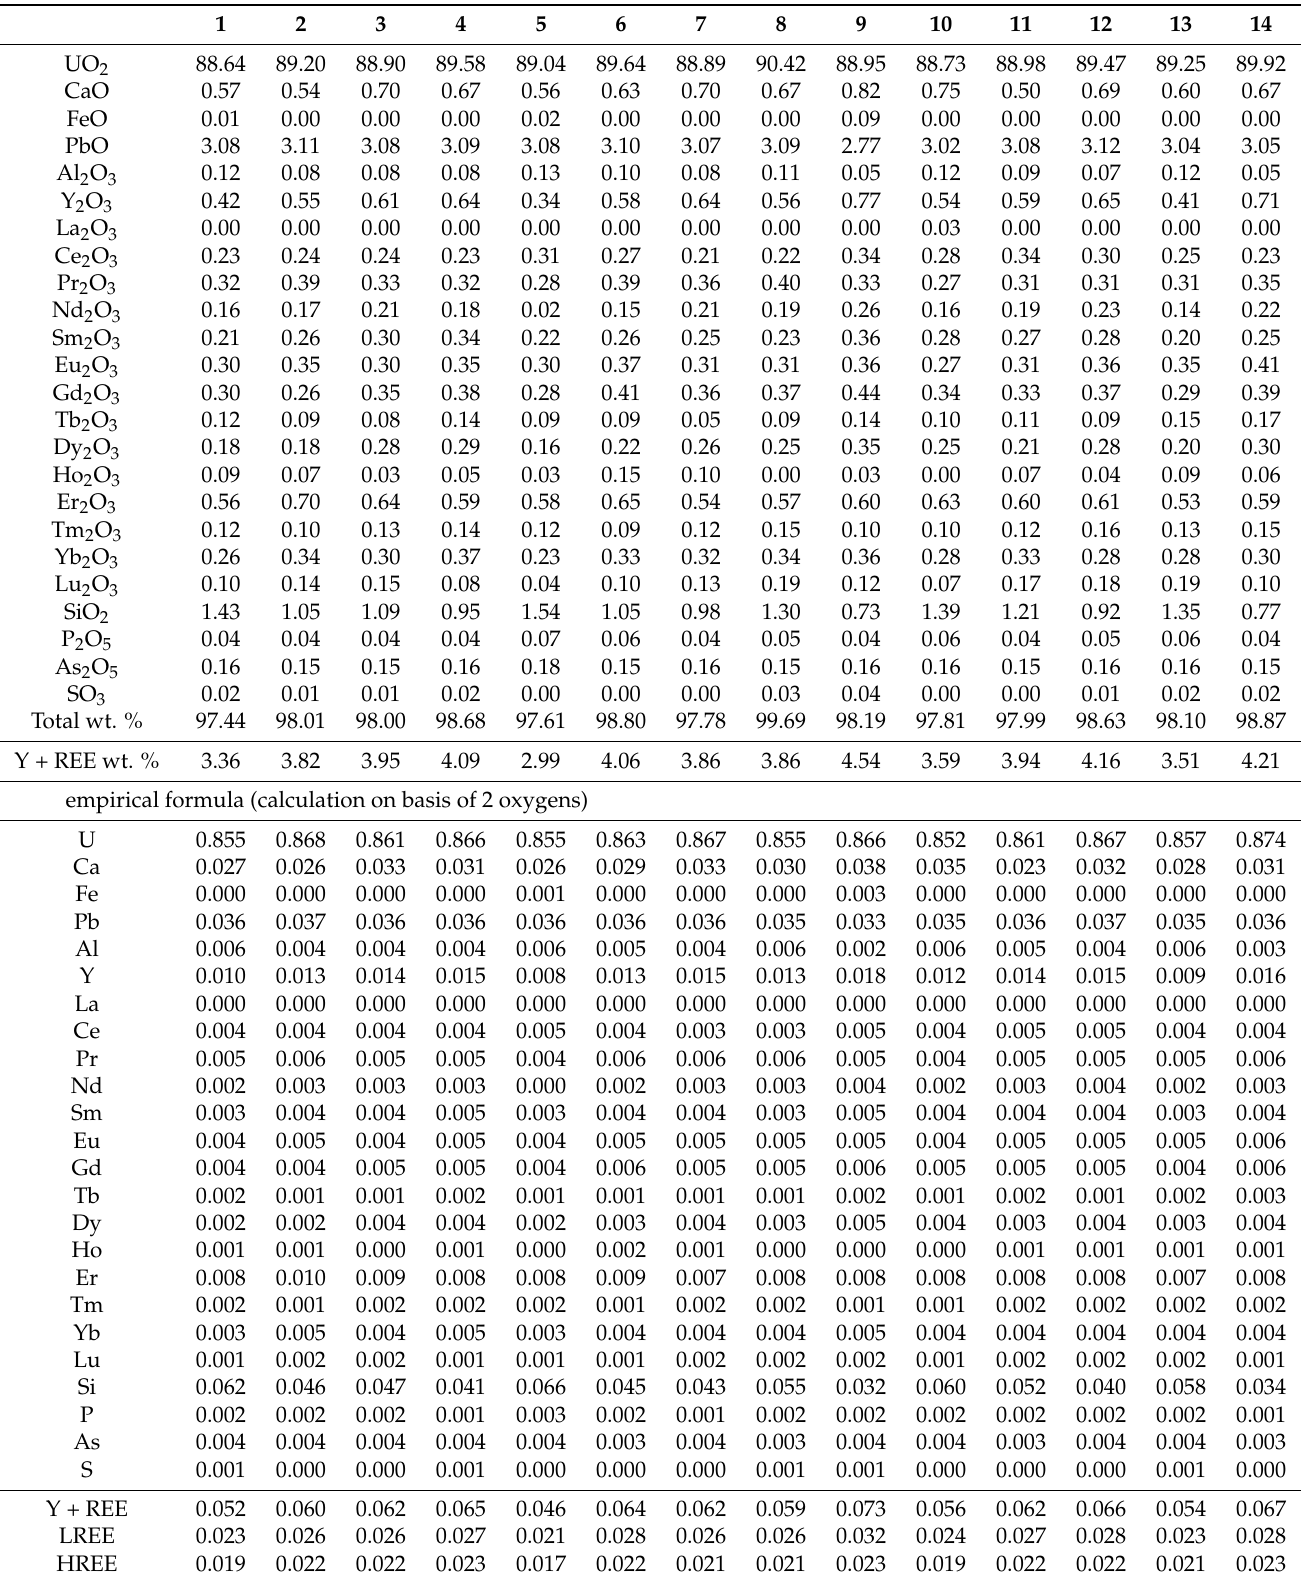
Table 2. Representative WDS microanalyses of uraninite from ˇCuˇcma (Majersk á